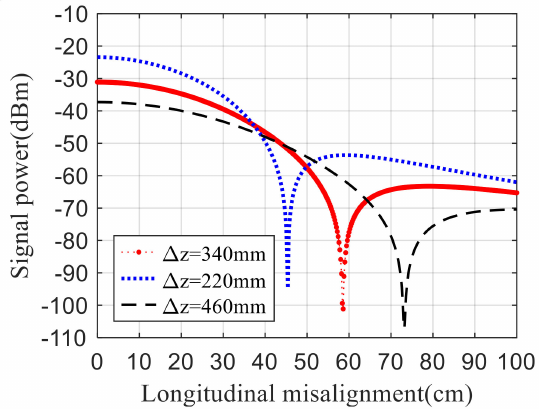
Figure 18. Variation of uplink received signal power at different vertical distances between the OAU and the